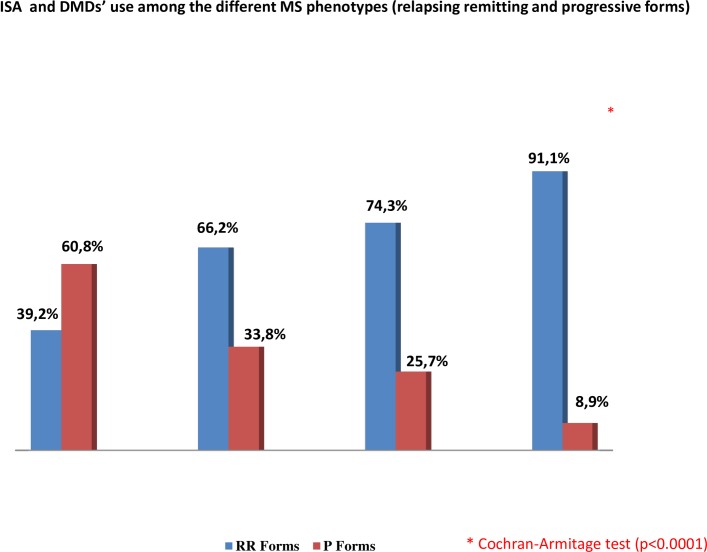
Shows the relation between the assigned therapy and the disease course in alla ISA subgroups and DMDs group.